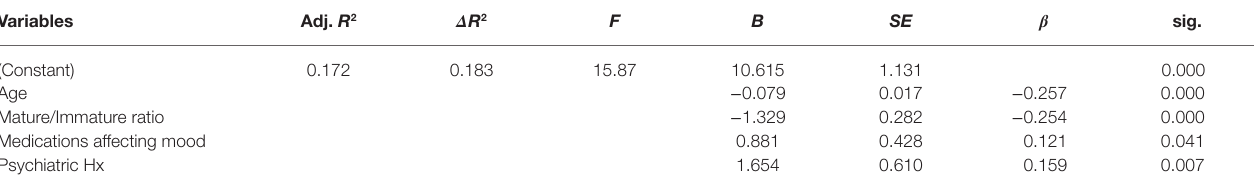
TABLE 3 | Multiple regression for age, mature/immature ratio, medications affecting mood, and prior psychiatric history a , and BDI cognitive scores b . Variables Adj. R 2 Δ R 2 B SE sig.